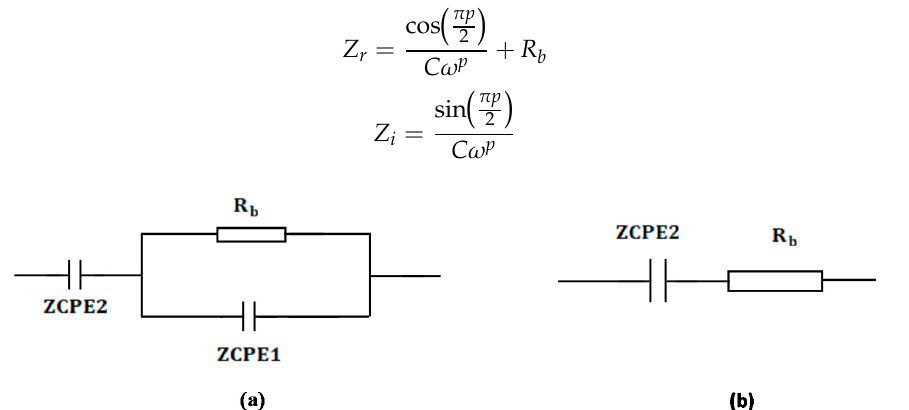
Figure 7. Experimental impedance and EEC fitting plots for ( a ) CMCF1, ( b ) CMCF2, ( c ) CMCF3 and ( d ) CMCF4 blended films at ambient temperature.